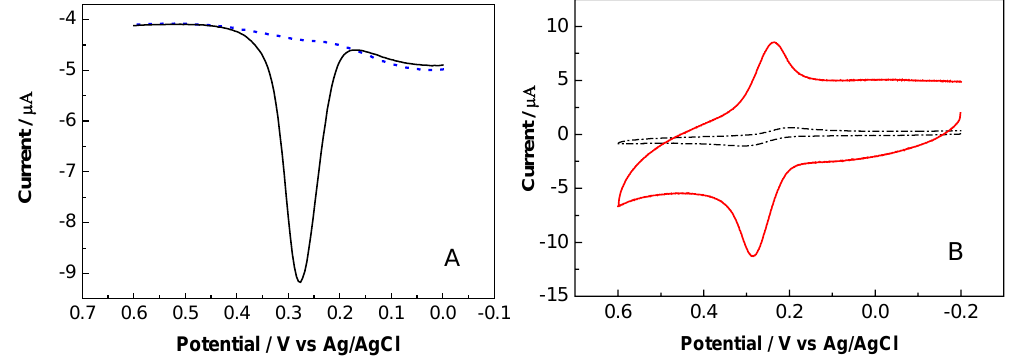
Figure 1. (A) Differential pulse voltammograms of DA at the modified electrode in the PBS (0.025 M, pH 6.0). Dot line: blank solution; Solid line: 5.0 × 10 -7 M DA. Accumulation potential under stirring, - 0.20 V; accumulation time, 60 s; quiet time, 30 s; scan rate, 5 mV·s -1 ; sampling width, 0.05 s; pulse amplitude, 50 mV; pulse period, 0.2 s. (B) Cyclic voltammograms of 2.0 × 10 -5 M DA at the bare GC electrode (dash line) and the modified electrode (solid line) in the PBS (0.025 M, pH 6.0). Scan rate: 100 mV·s -1